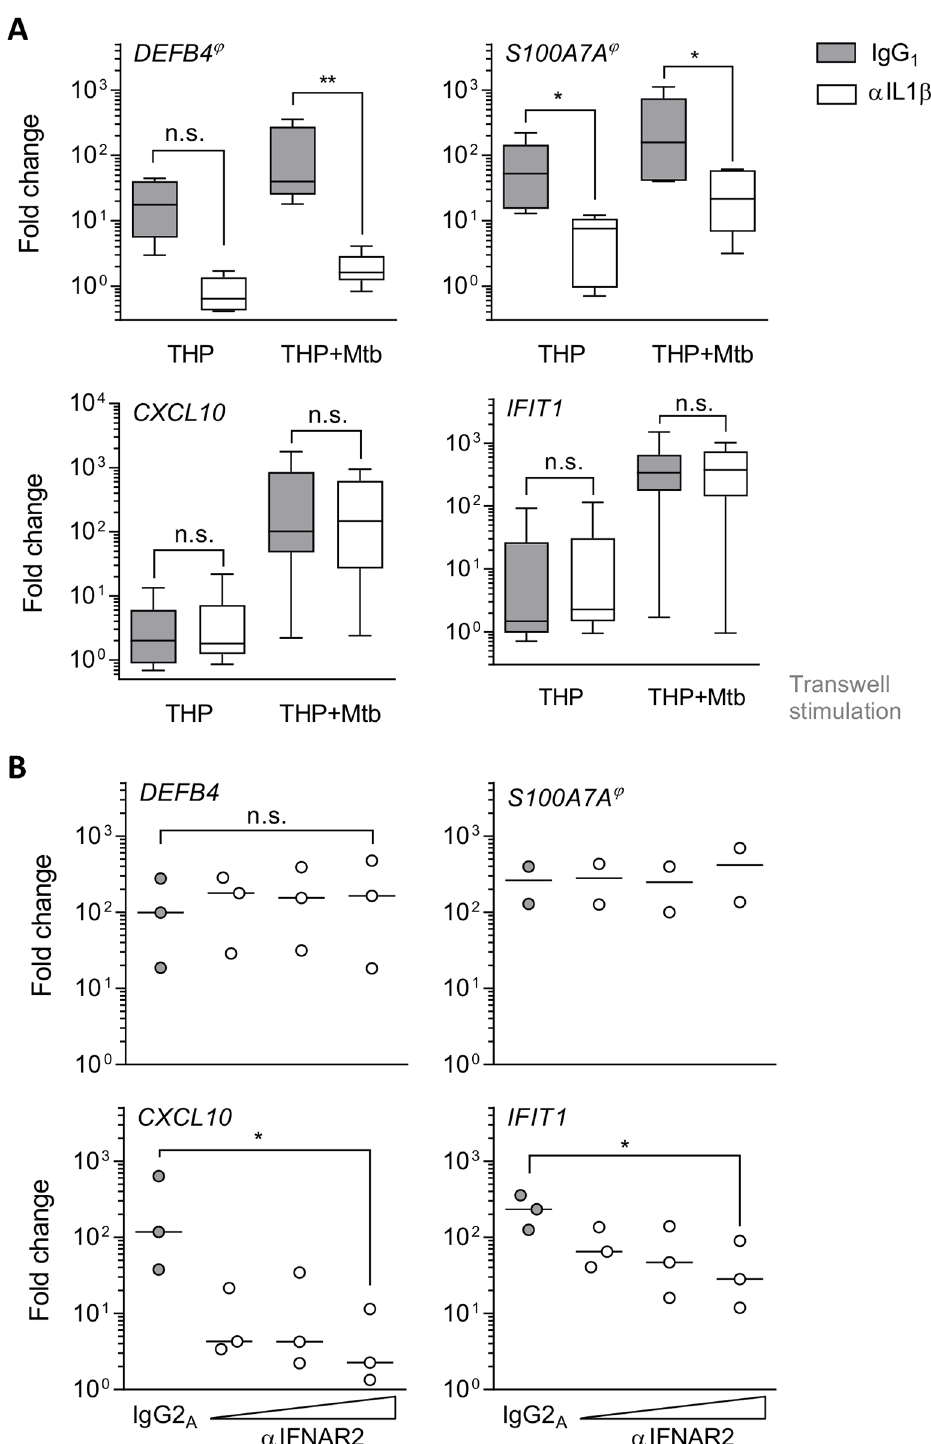
Fig 7. Mtb-driven inflammation activatesPBECs in an IL1 β and type I IFN signalling dependent manner. (A) PBECs were co-cultured with infected or uninfectedTHP-1 cells in the presenceof α L1 β or IgG 1 (isotype control) as indicated. After 24h, geneexpressionwas measuredby RT-PCR. Expression is shown as fold changeover unstimulated (n = 6). Boxplots show median and range. (B) PBECs were exposedto Mtb- infected THP-1 cells (MOI5) in the presenceof increasing concentrations of α IFNAR2 (5, 10 and 20 μ g/ml) or